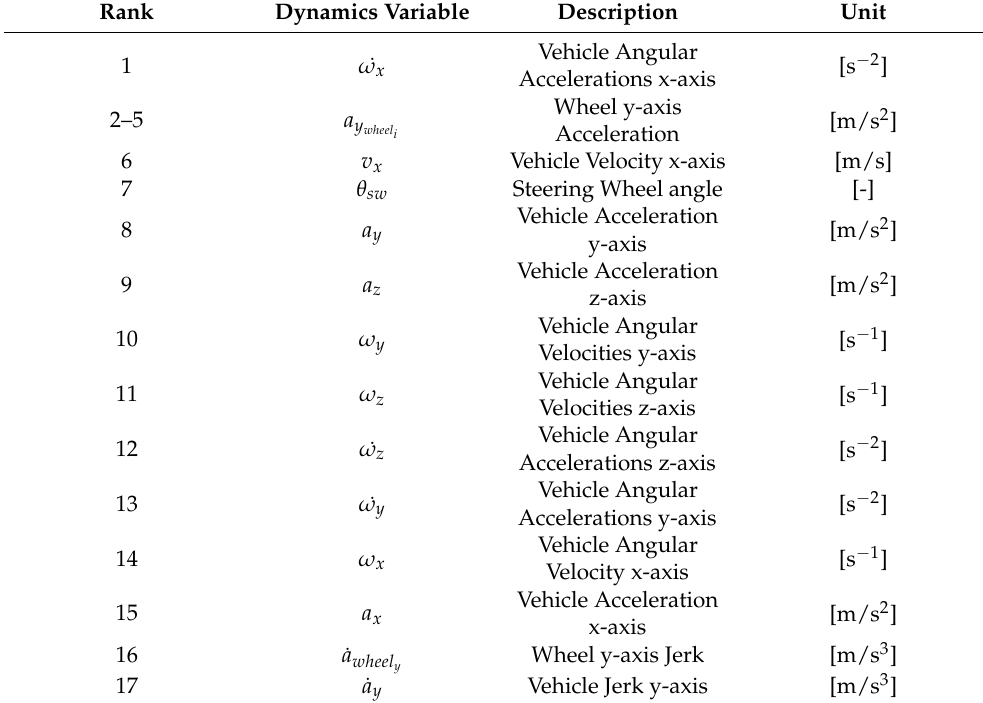
Table 3. Sorted list of variable following wrapper methods Rank Dynamics